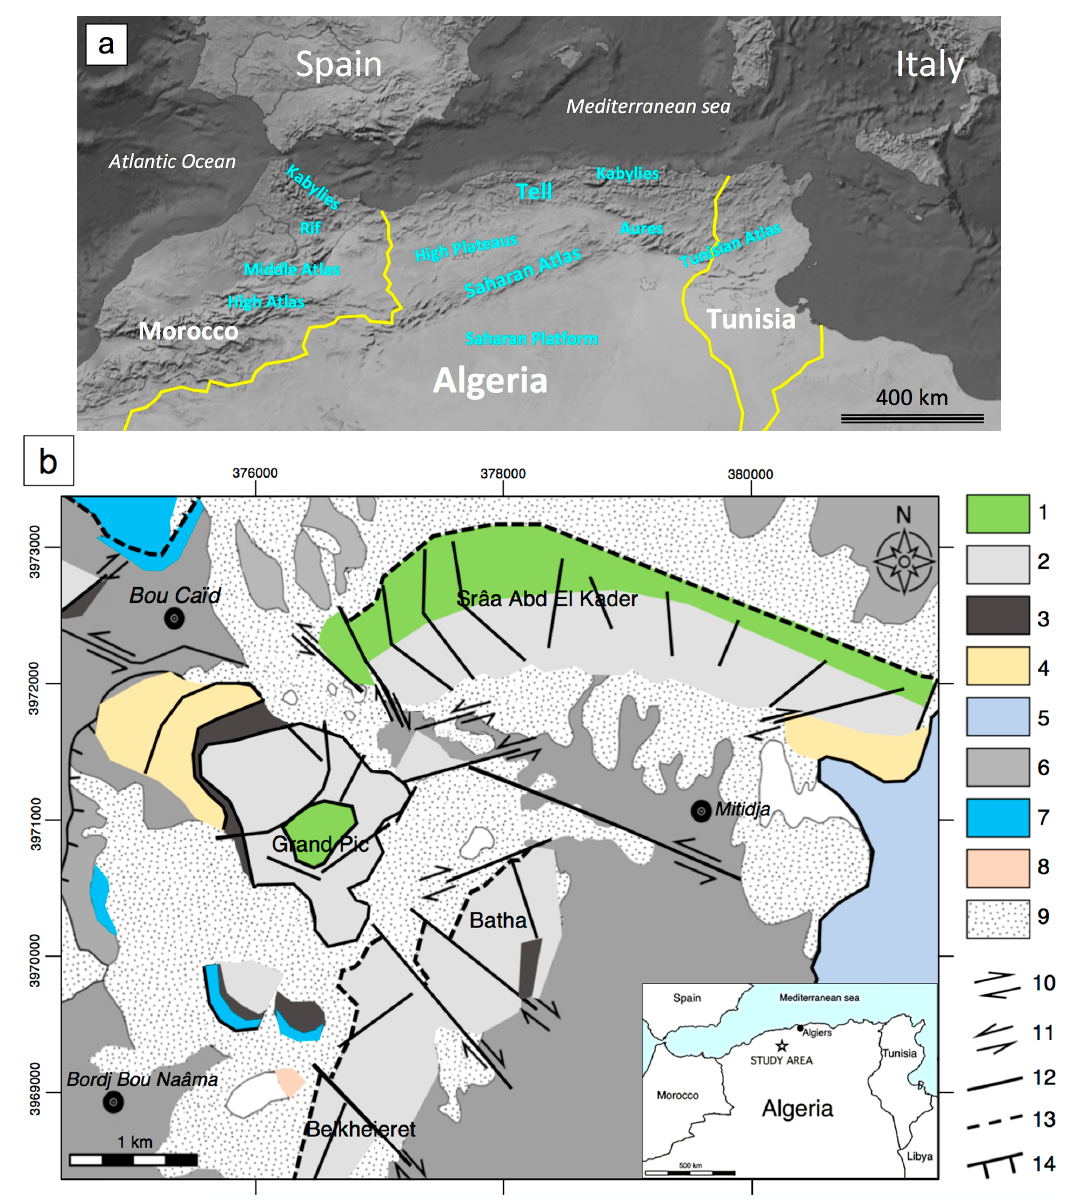
Figure 1. ( a ) Structural domains of North Africa (see text). ( b ) Schematic map of the Ouarsenis culminating zone (adapted after [11]). 1: Early Liassic; 2: Late and Middle Liassic; 3: Oxfordian; 4: Tithonian and Berriasian to Hauterivian; 5: Albian; 6: Barremian; 7: Cenomanian; 8: Early Miocene; 9: Quaternary; 10: dextral strike-slip; 11: sinistral strike-slip; 12: fault; 13: